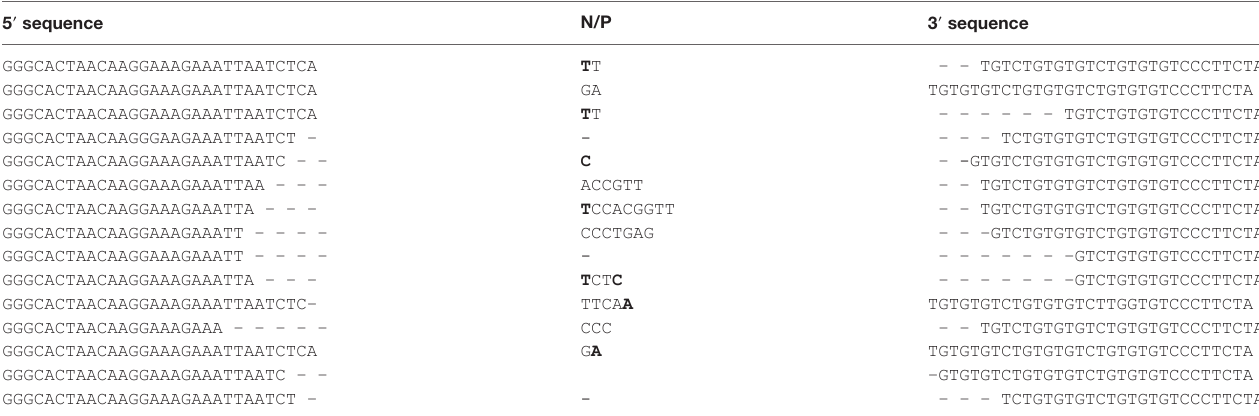
TaBle 2 | Coding joints sequences of Bcl11b cryptic recombination events exhibit the features of the RAG-mediated signature. 5 ′ sequence n/P 3 ′ sequence